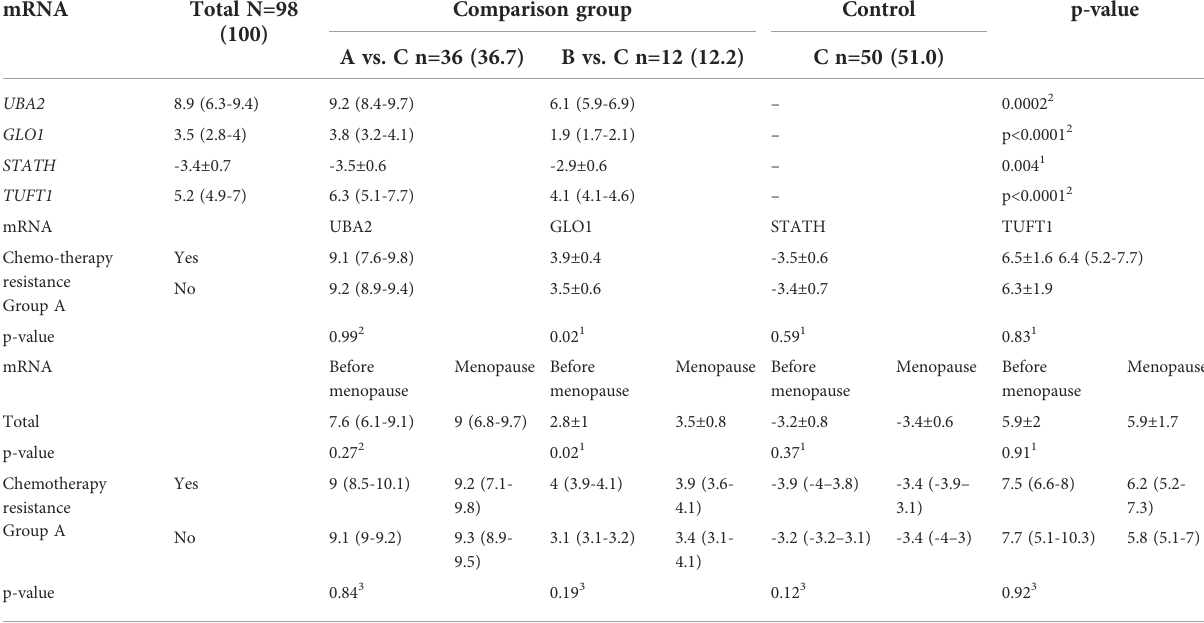
TABLE 4 Expression pattern of selected genes in the study groups (A and B) in comparison with the control group (C) obtained by RT-qPCR, including patients undergoing chromotherapy (in A group) and menopause (total and in A group).